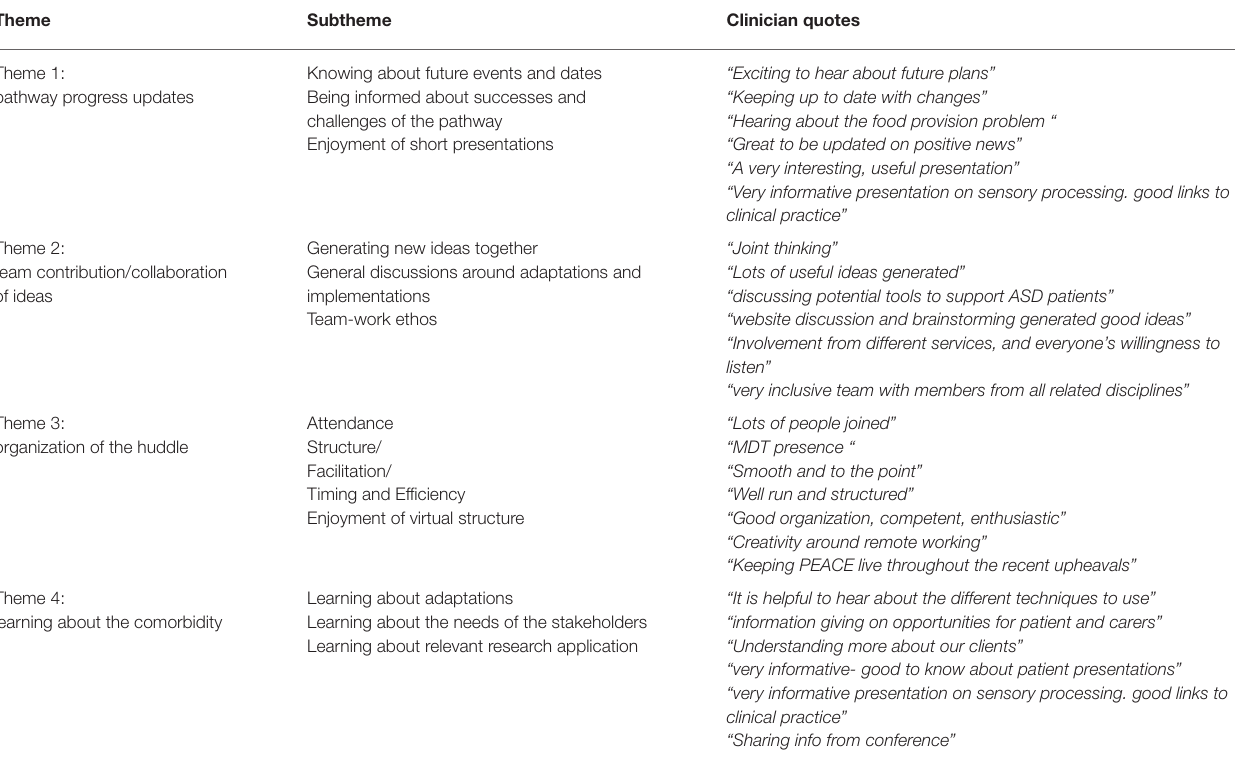
TABLE 3 | A table showing example quotes from each theme and subtheme identified from responses to question 2 “what went well in the